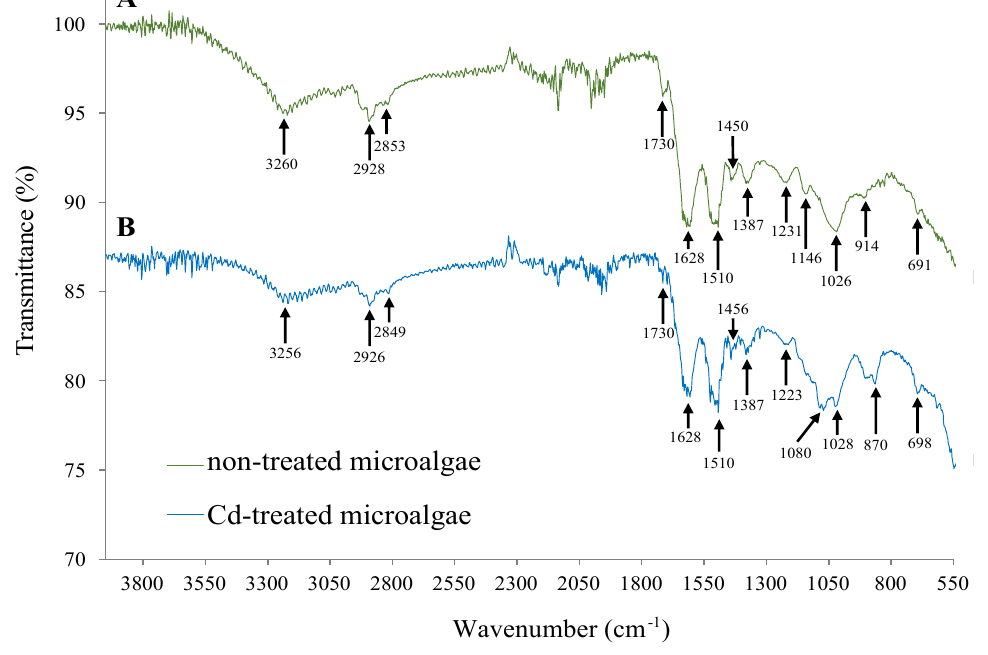
Figure 2. FTIR-ATR spectra of Oscillatoria sp. grown under control conditions ( A ) or after 24-h Cd exposure ( B ). The broad band at 3500–3050 cm − 1 was characteristic of the O–H and N–H groups [30], whereas the bands at 2928 and 2853 cm − 1 refer to the asymmetric and symmetric vibration of methylene (CH 2 ), respectively [28]. The peaks at 1730 cm − 1 correspond to the C=O bond. The bands within the region of 1500–1000 cm − 1 were characteristic of the ester group. Several peaks were obtained in this region, indicating the stretching